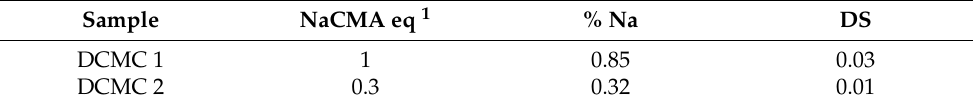
Table 2. Degree of substitution of synthesized dicarboxymethyl cellulose sodium salt.